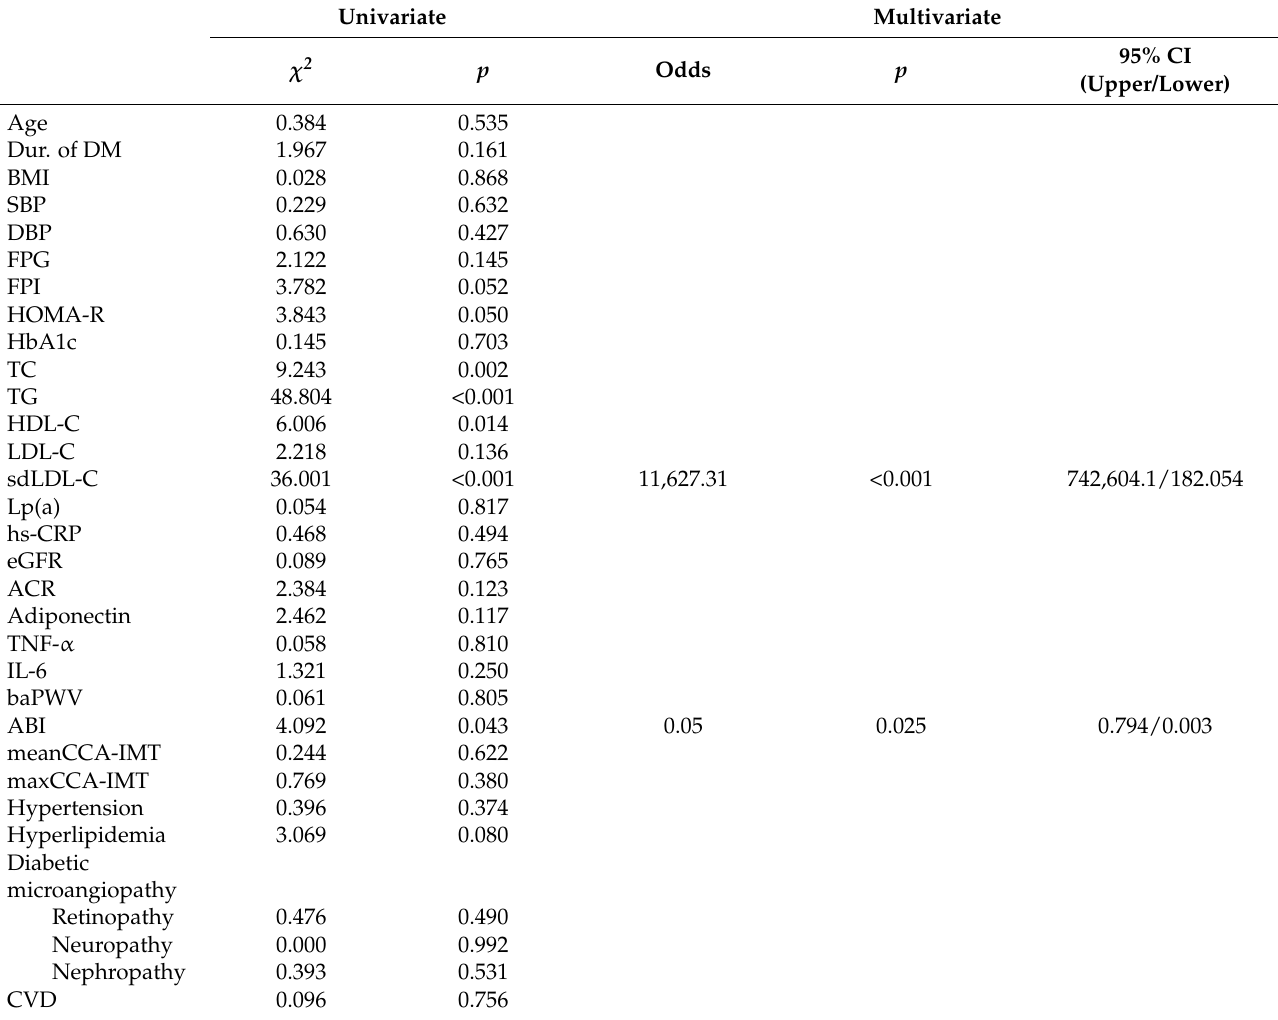
Table 5. Logistic regression analyses for the factors of RemL-C in male participants with T2DM. Univariate